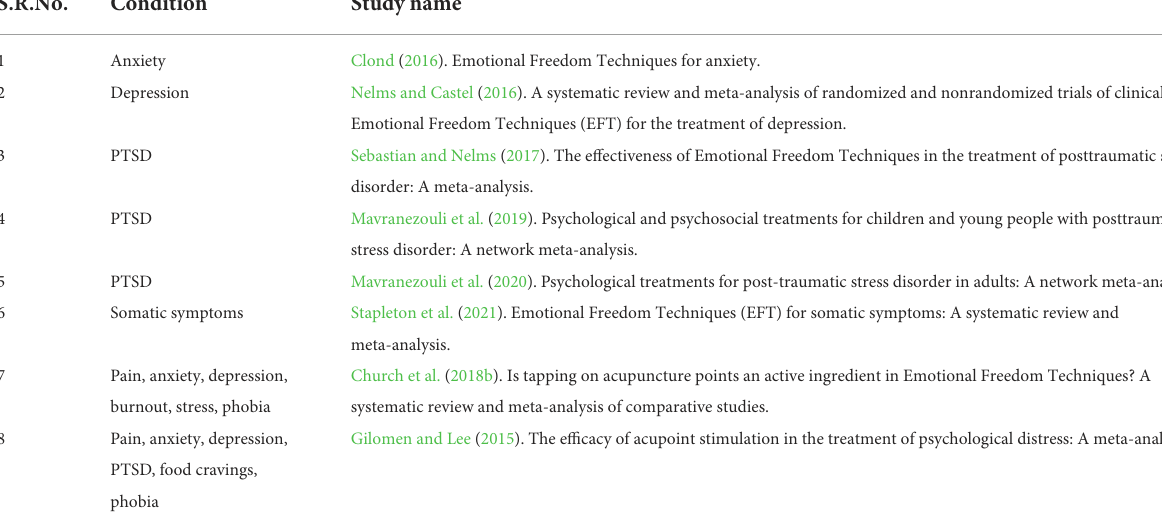
TABLE 1 EFT systematic reviews with meta-analyses published since 2013.